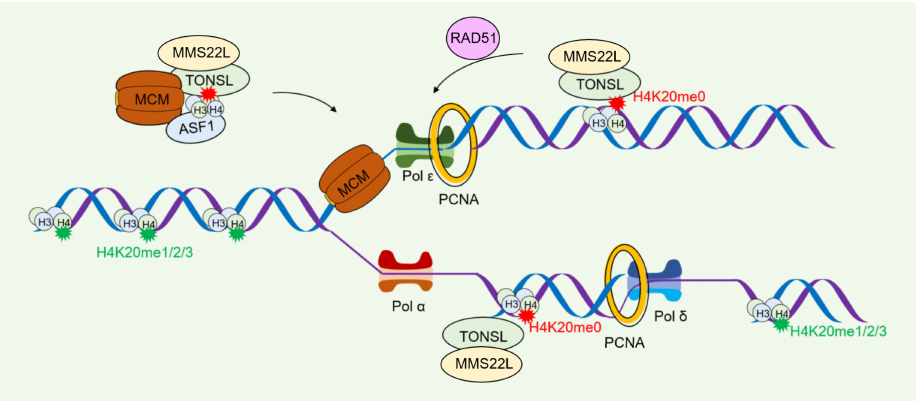
Figure 5. DNA damage repair by chromatin assembly in human. Encounter of a replication fork with DNA lesions that hamper its advance triggers the DNA damage repair (DDR) response. In human cells, MMS22L-TONSL mediates the deposition of newly synthesized histones, binds to unmethylated H3-H4K20 (H3-H4K20me0), and promotes RAD51 recruitment and replication fork recombination